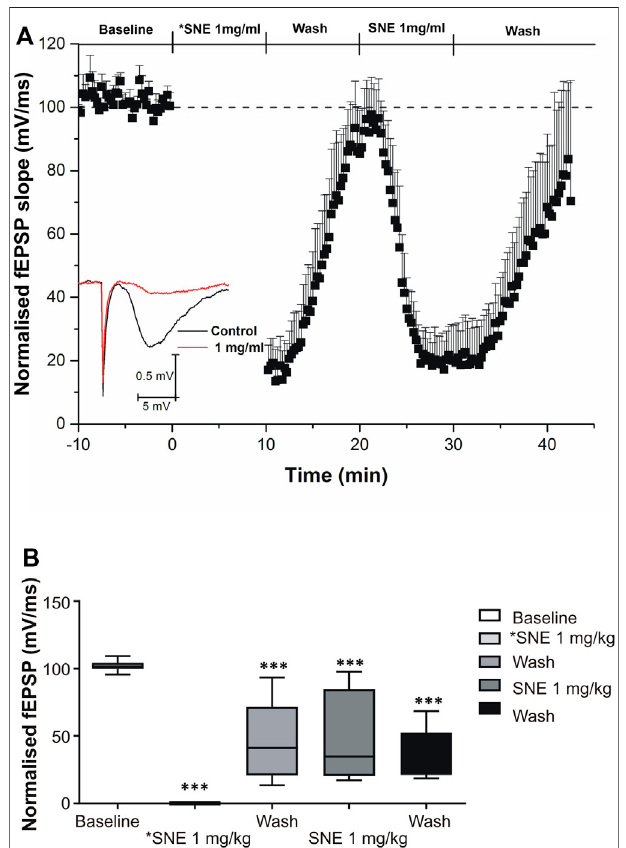
FIGURE 4 | (A) Effect of SNE (1 mg/ml) on the slope fEPSPs without stimulation (*SNE 1.0 mg/ml) and with stimulation (SNE 1.0 mg/ml). (B) The box and whiskers graph is the total effect calculated form the AUCs of the graph above it. Data is mean ± SEM (n (cid:2) 5). *** p < 0.001 compared with baseline, one-way ANOVA followed by a Dunnett ’ s multiple comparison test.